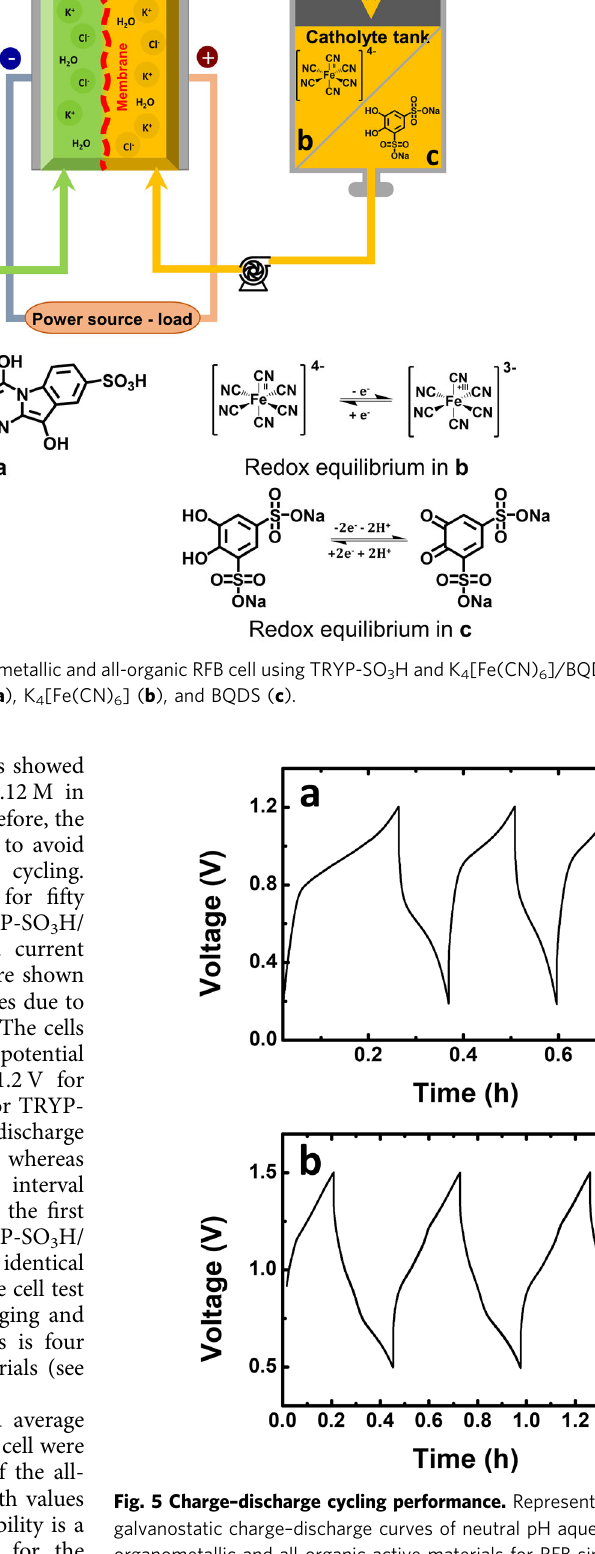
5.0 mM of TRYP-SO 3 H in 1.0 M KCl solution as supporting electrolyte measured at the third cycle. a 10.0 mM of K 4 [Fe(CN) 6 ]·3H 2 O as catholyte. b 5.0 mM of BQDS as